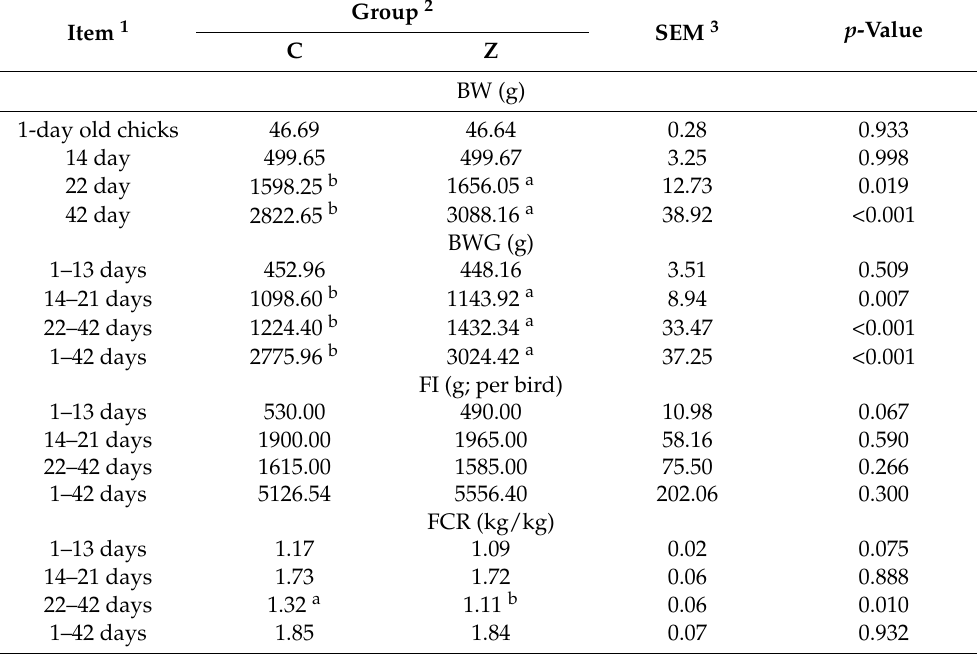
Table 3. Growth performance of broiler